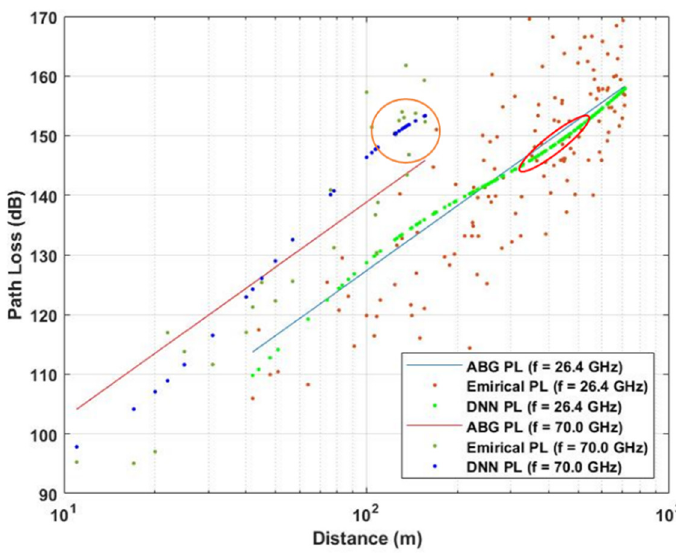
Figure 11. Path loss models and empirical data for mid 5G band.